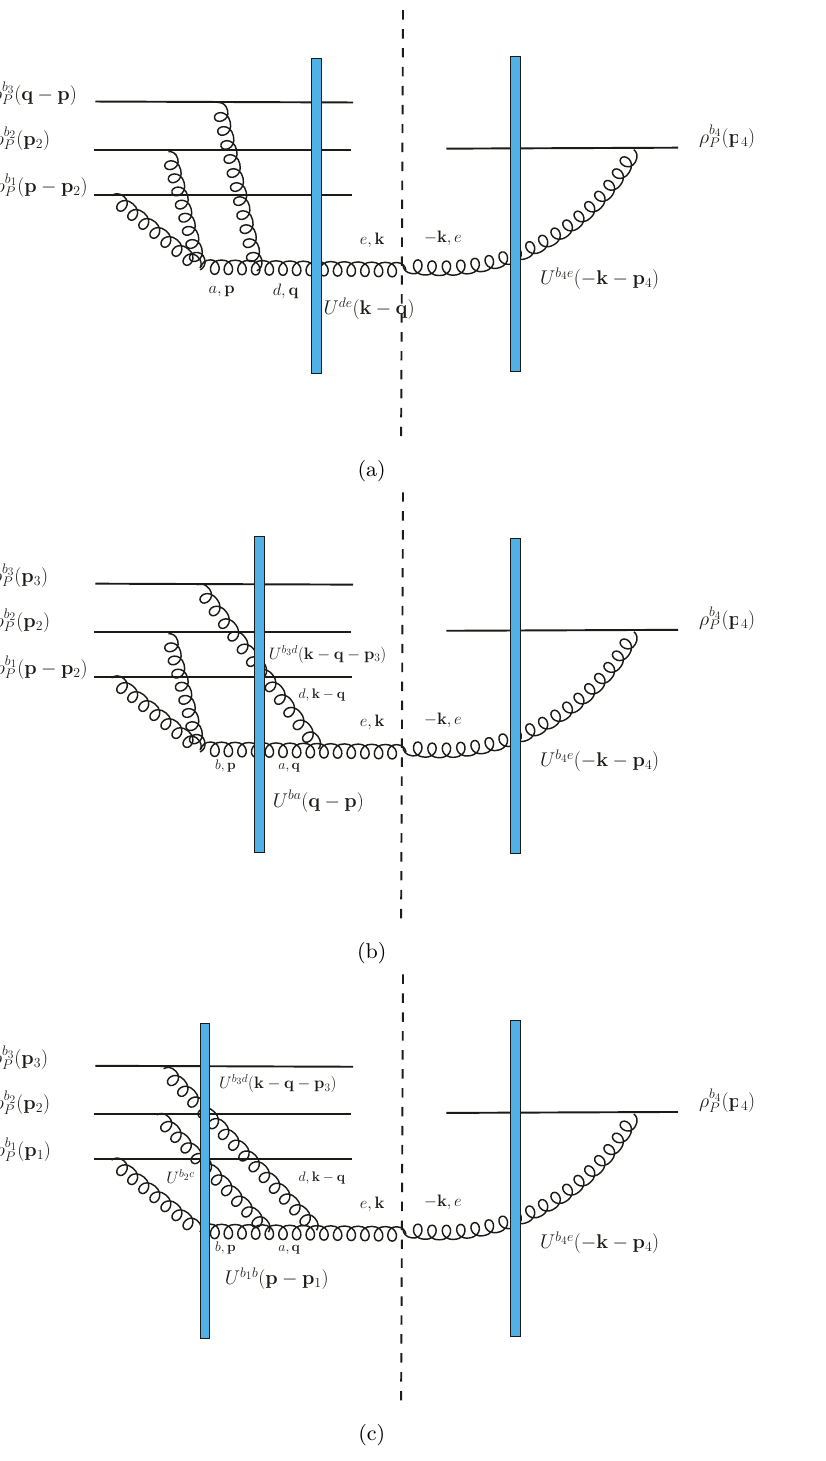
Figure 7 . Color structures for the terms in M ∗ lines. The dashed line separates the amplitude and the complex conjugate amplitude. In (a) two gluon lines crossing the target nucleus, (b) three gluon lines crossing the target nucleus and (c) four gluon lines crossing the target